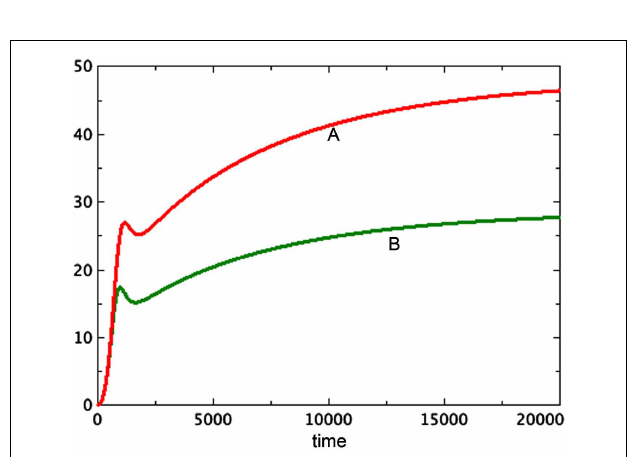
FIGURE 5 |Two runs are shown with different rates of necrosis: e Q,N = 0.002 (top) and e Q,N = 0.004 (bottom). a = 0.01, b P,Q = 0.005, c Q,P = 0.005, d = 0.0002, f = 0.001, h = 0, m = 0.0001, P 0 = 0.01, Q 0 = 0.01, N 0 = 0.